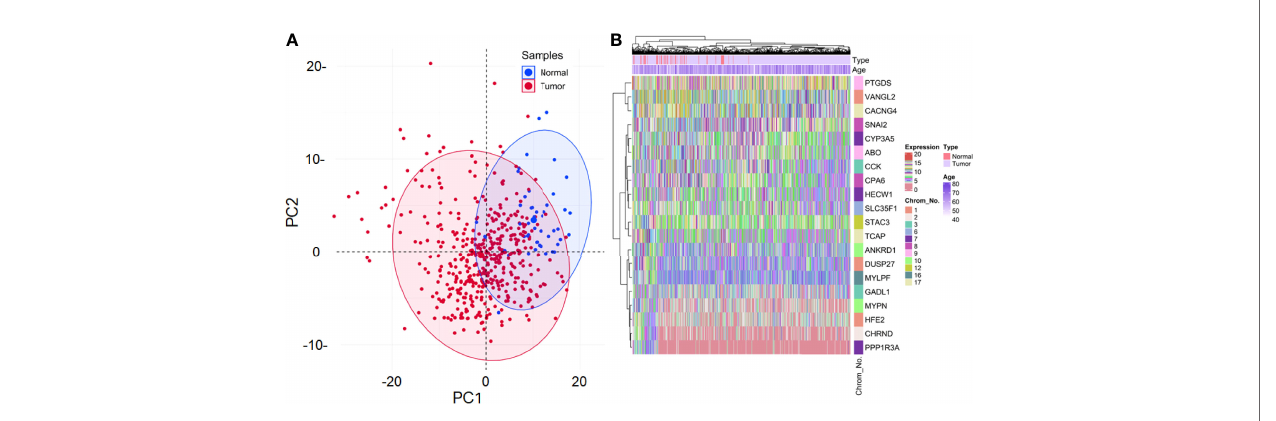
FIGURE 2 | (A) Principal component analysis (PCA) plot shows the expression variability of 221 DEGs across all samples. Each point in the plot signi fi es the relative expression value of all DEGs dimensionally reduced to sample type leading to distinct cluster formations. Blue and red points signify normal and tumor samples, respectively. The percentage of total variation accounted for by the 1st (30.2%) and 2nd (9.9%) principal components are shown on the x and y axes, respectively. (B) Annotation heatmap showing the expression distribution of top 10 up and downregulated PRAD-speci fi c DEGs. Cluster dendrograms representing Euclidean distance-based hierarchical clustering for both rows and columns are presented along the left and top sides of the plot. Sample type (red for normal and violet for tumor) and age annotation bars are presented at the top of the heatmap. The location of each gene on its respective chromosome number is presented in the right panel as the row annotation bar (multi-colored bands).